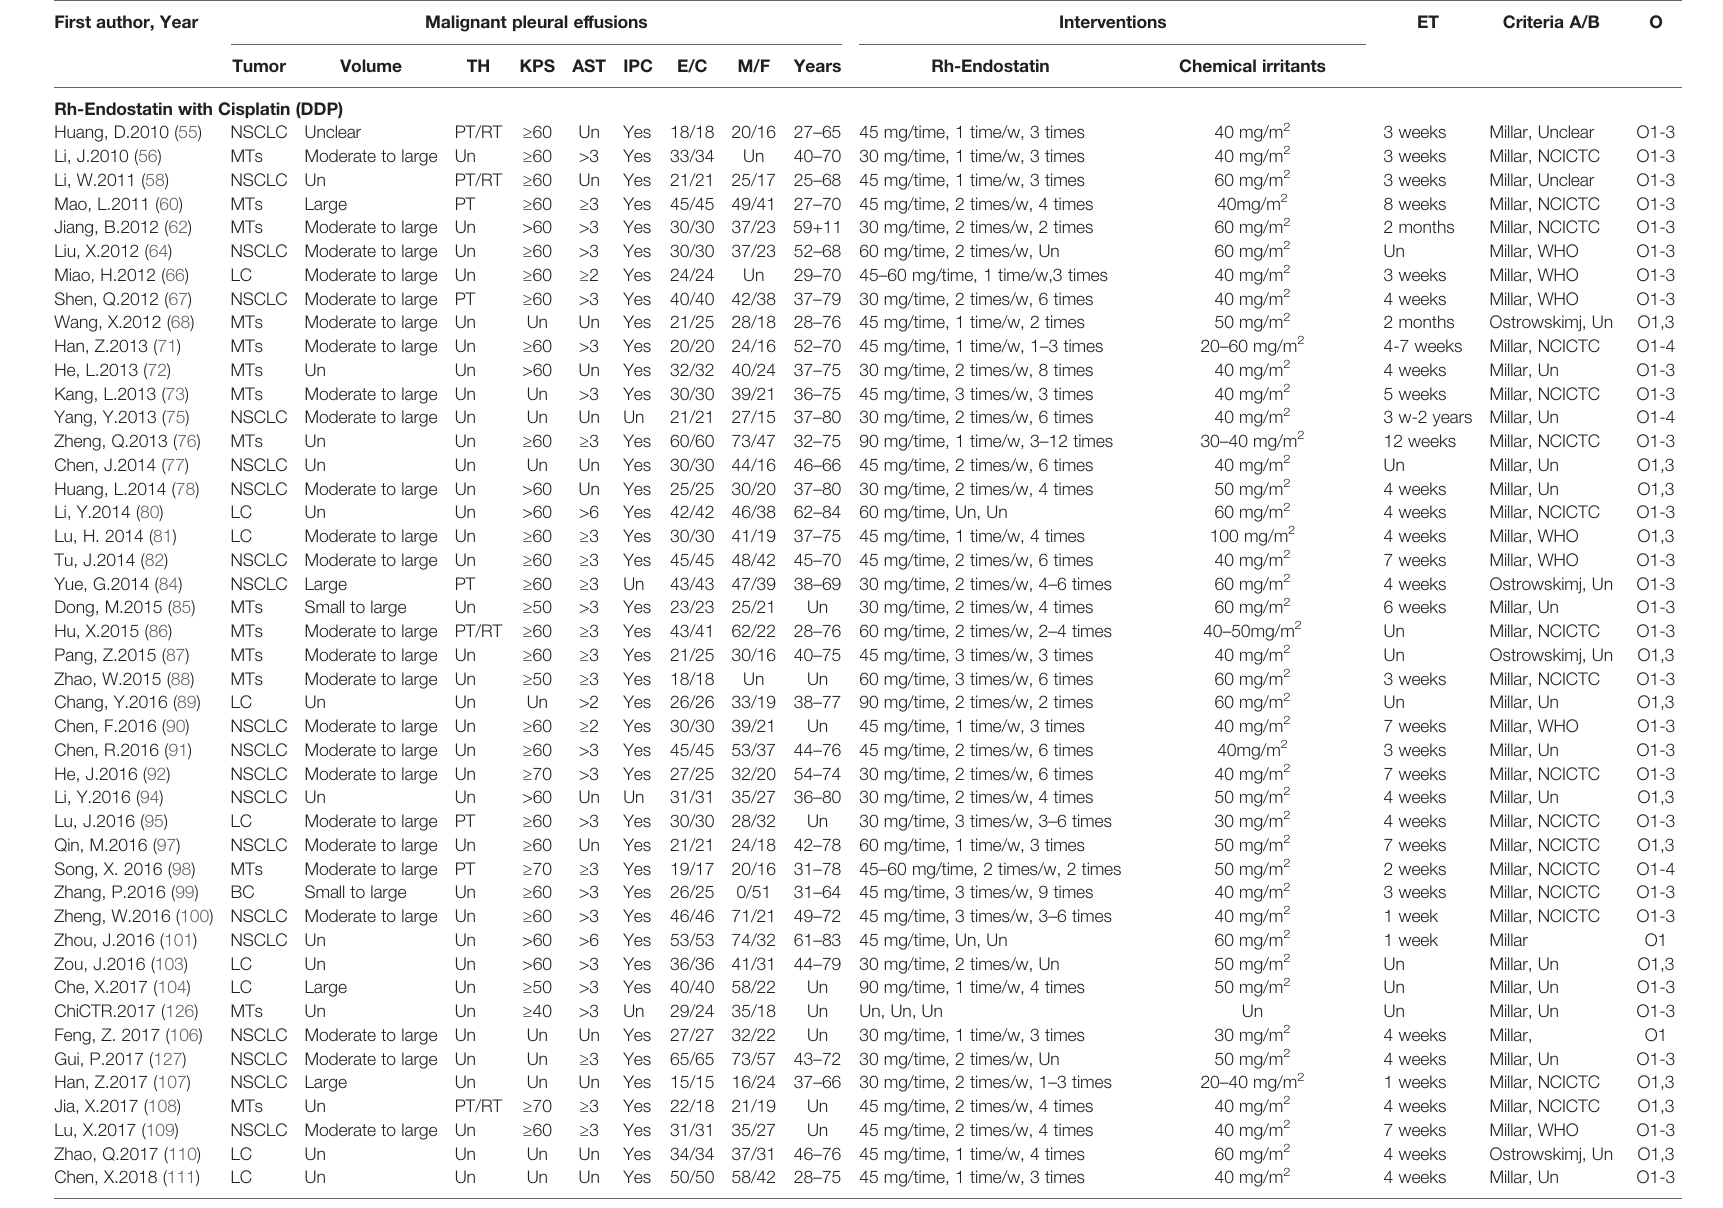
TABLE 1 | Characteristics of the included